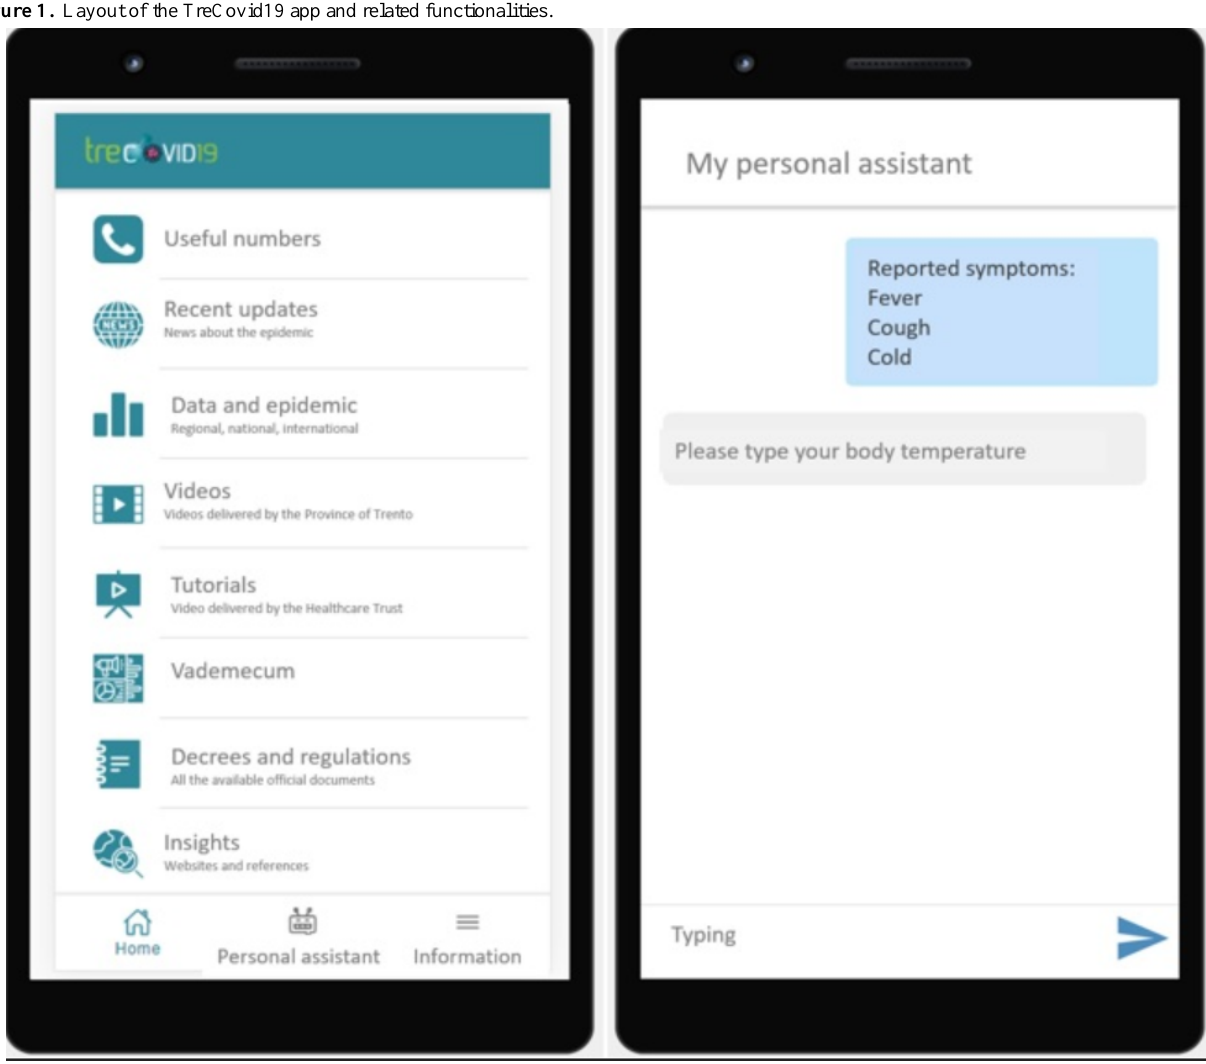
Figure 1. Layout of the TreCovid19 app and related